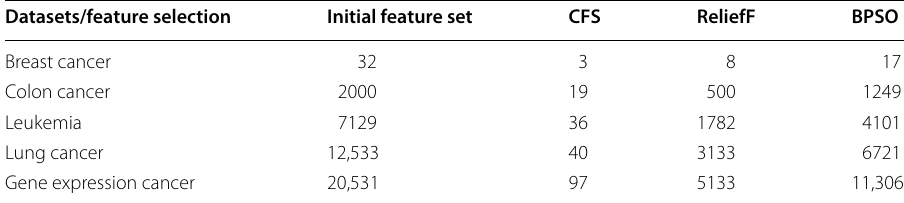
Table 7 Number of selected features per algorithm Datasets/feature selection